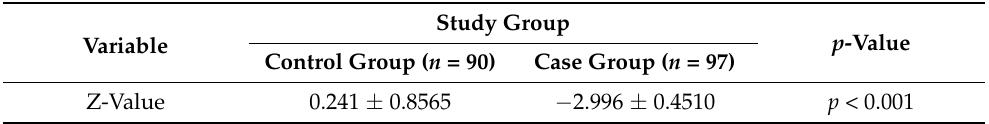
Table 4. Comparative analysis of Z-values between the study groups.